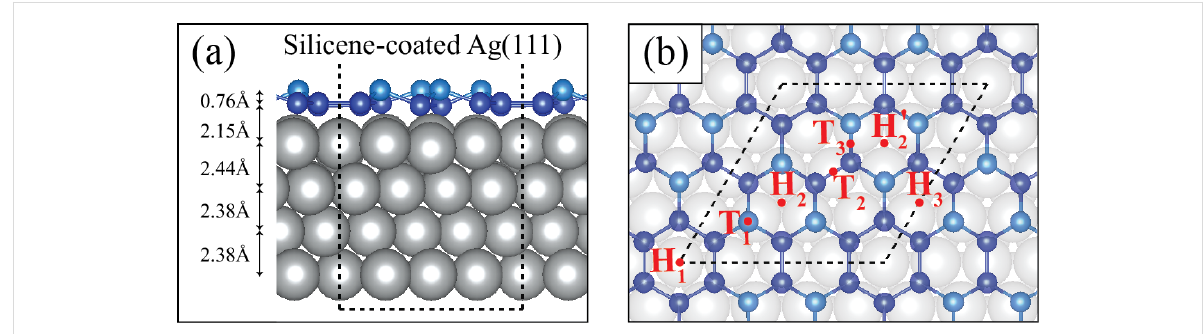
Figure 3: (a) Side view of the silicene-coated Ag(111) supercell structure and (b) top view of the silicene-coated Ag(111) supercell structure with possible oxygen-capture sites. Definitions and oxygen binding energies of all sites are given in Table 1.